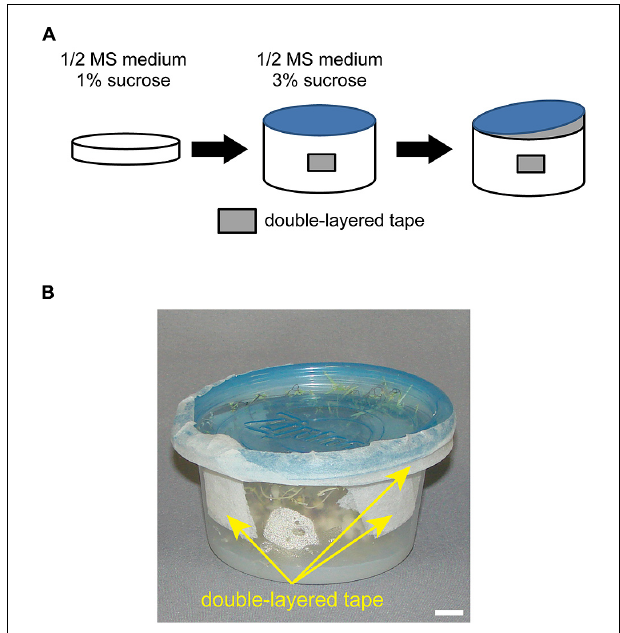
FIGURE 1 | Overview of homozygous ppi2-2 cultivation using plates and Ziploc ® containers. (A) Homozygous ppi2-2 plants were first grown in MS plates (left) and then transferred into a Ziploc ® container (middle). The Ziploc ® container has four holes covered with double-layered surgical tape. At a later stage, the lid of the Ziploc ® container was partially opened (right), and a gap between the lid and the container was sealed with double-layered surgical tape. (B) Ziploc ® container used in this study. Bar = approximately 1 cm.